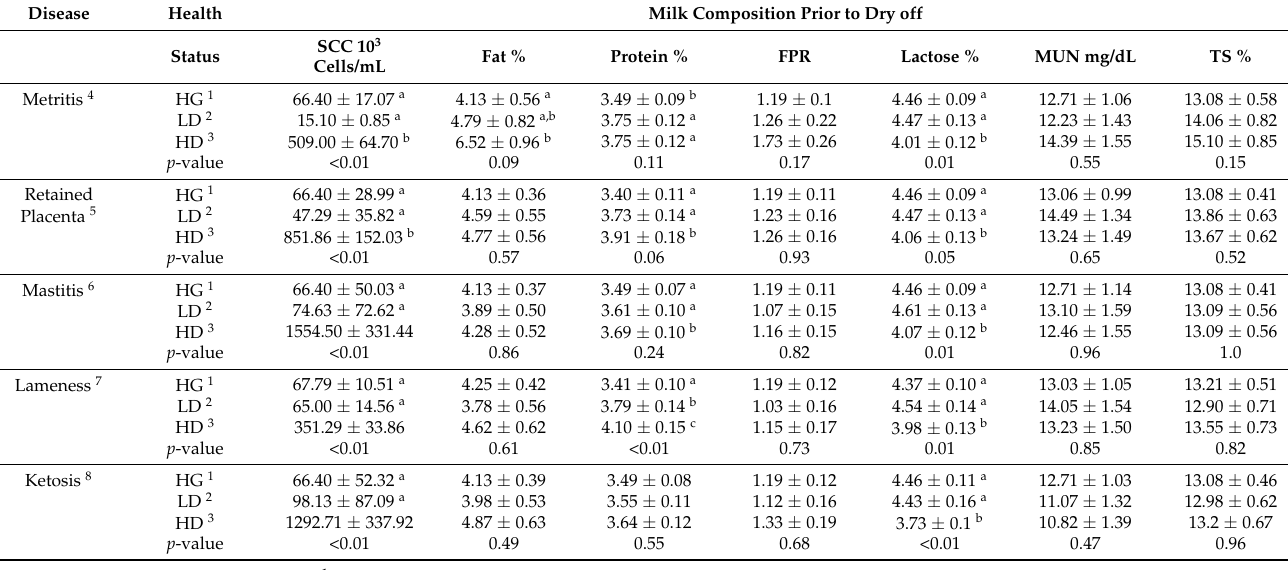
Table 3. Alterations in milk composition (fat, protein, fat:protein ratio, milk urea nitrogen (MUN), total solids (TS), and somatic cell counts (SCC) one week prior to dry off in dairy cows diagnosed with postpartum